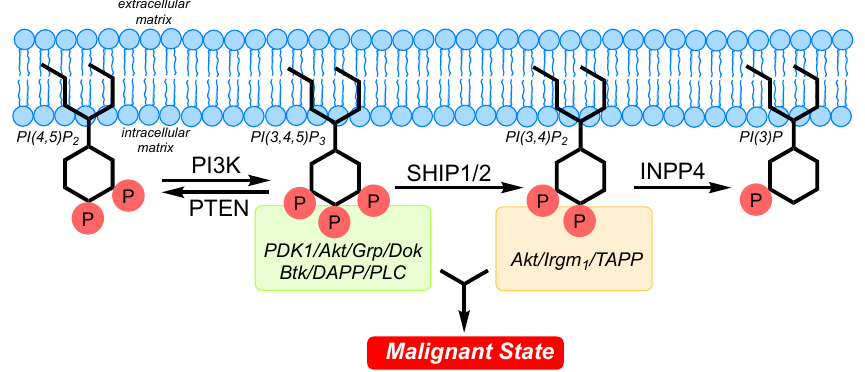
Figure 1. Malignancy and the “ Two PIP Hypothesis” . Signaling an imbalance in the amounts of both PI(3,4,5)P 3 and PI(3,4)P 2 may lead to the development of a malignancy. Consistent with the “ Two PIP Hypothesis”, levels of the SHIP1 product PI(3,4)P 2 are increased in several leukemia cells lines [19], while increased amounts of PI(3,4)P 2 in inositol polyphosphate 4-phosphatase type II (INPP4A/B) knockout mice are implicated